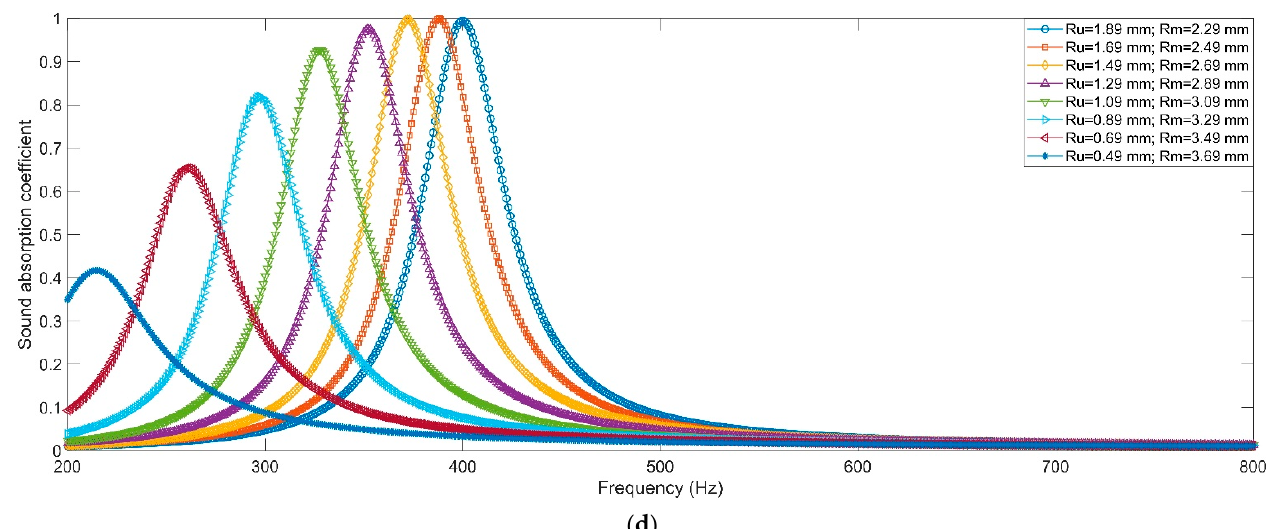
Figure 10. The sound absorption property of HR with the aperture for various tangent sectional shapes and different parameters. ( a ) Common trapeziform; ( b ) reverse trapeziform; ( c ) dumbbell; and ( d ) olive.